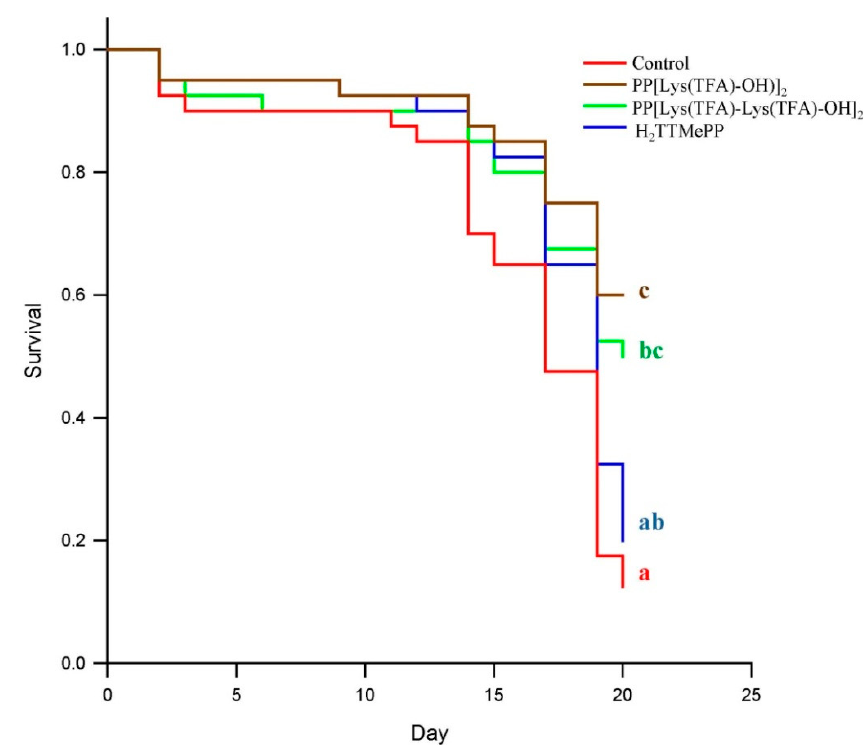
Figure 3. Kaplan-Meier survival curves for honeybees after infection with Nosema ceranae microsporidia treated with porphyrin solutions. A log-rank post hoc test was used to determine which curves were significantly di ff erent from each other ( p = 0.001). Curves labeled with the same letter are not significantly different.